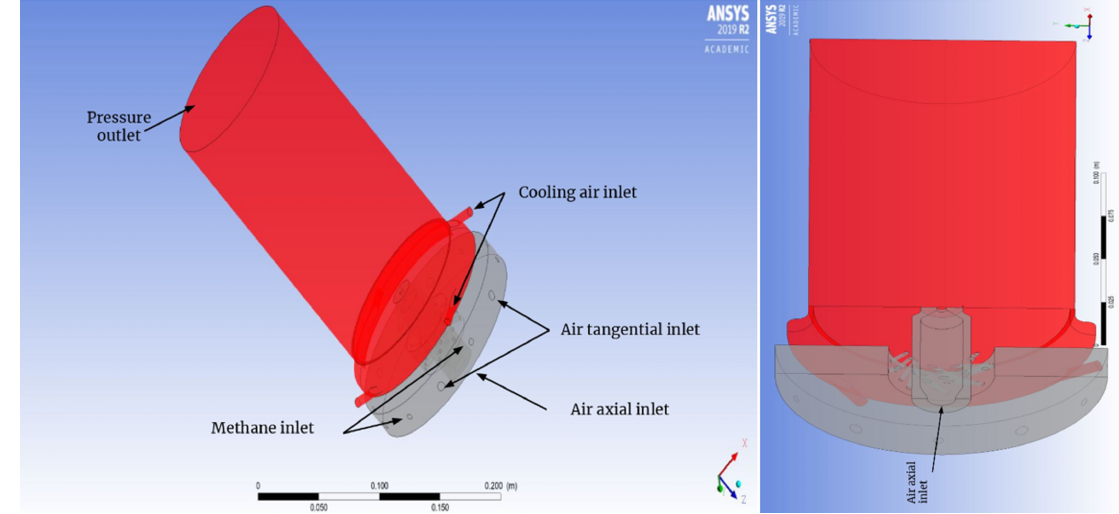
Figure 4. Sketch of the combustor and computational